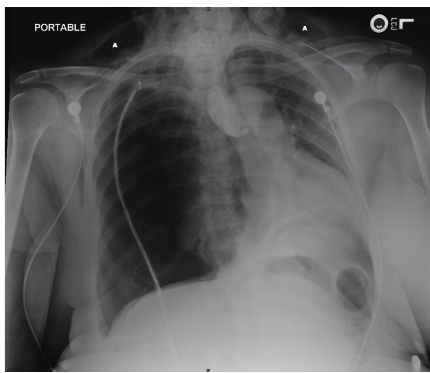
Figure 2: Tension pneumothorax. (a) Cervical